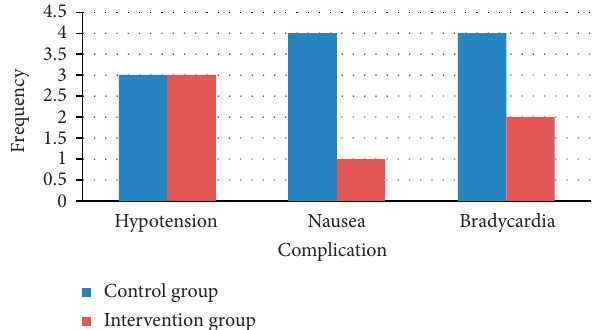
Figure 5: Frequency of complications in two groups. Te diference in all of the side efects frequency was not signifcant ( P >